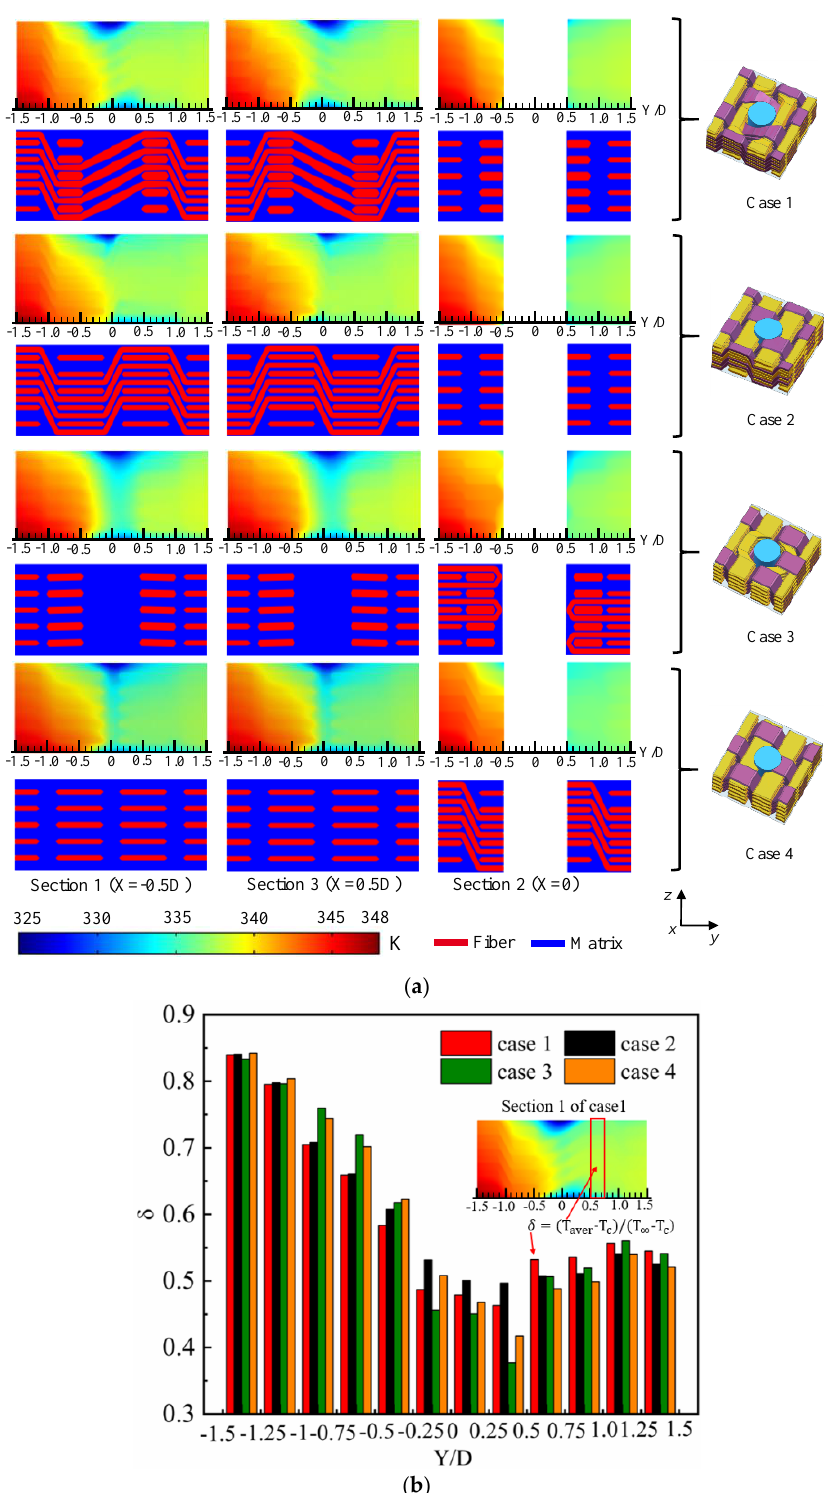
Figure 13. Temperature fields and heat flux direction of different cases on CCR: ( a ) temperature fields of different cases on sections 1 to 3, ( b ) average dimensionless temperature δ distribution of section 1.